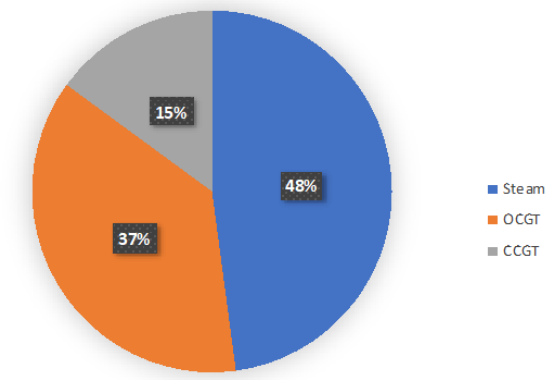
Figure 3. Distribution of the KSA’s generation capacity by technology type. The KSA’s power system is interconnected with the Gulf Cooperation Council (GCC) countries through 400 kV high-voltage direct-current (HVDC) double circuit lines, which operate at different frequency levels [2,27,28]. As shown in Figure 4, the GCC interconnec- tion includes 900 km of overhead lines and a 37 km submarine cable to Bahrain, which allow for the interchange of electricity between all GCC grid emergency situations to reduce the spinning reserves of all of the GCC’s grids and improve their reliability. The GCC allows the KSA’s power system to interchange a maximum of 1200 MW during emergency situations [2,27,28]. However, this back-to-back HVSC interconnection to the GCC comes in the third stage of the frequency control loops following a power disturbance and does not contribute to the fast ancillary services in the KSA’s grid because they are not synchronously connected